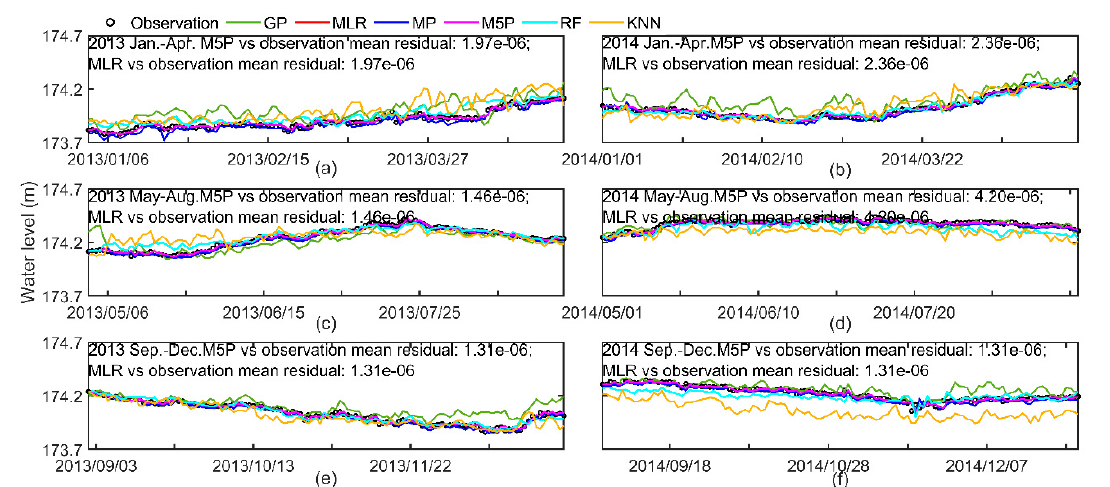
Figure 5. Comparisons between the predictions of six ML models and observations for water level